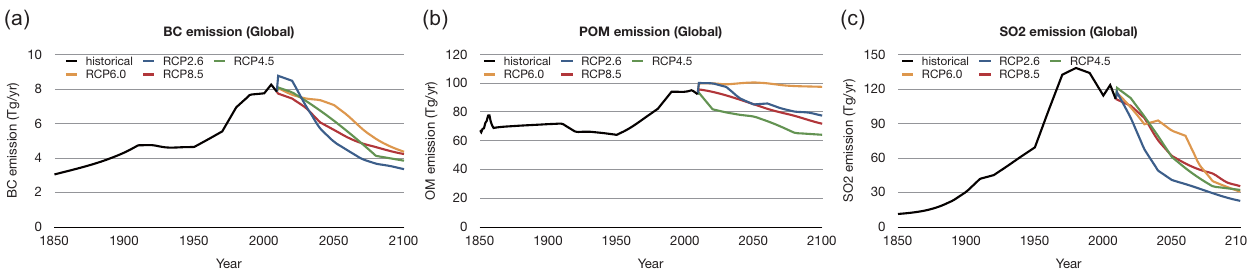
Fig. 2. Time series of annual and global total emissions of (a) BC, (b) POM, and (c) SO 2 according to the RCPs. The historical period is shown in black, and the four RCPs are shown in